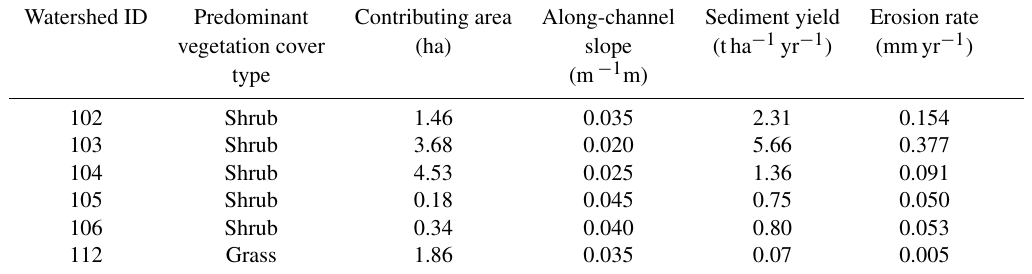
Table 1. Sediment yield data and watershed characteristics. The erosion rate calculation assumes a soil bulk density of 1500kgm − 3 . Watershed